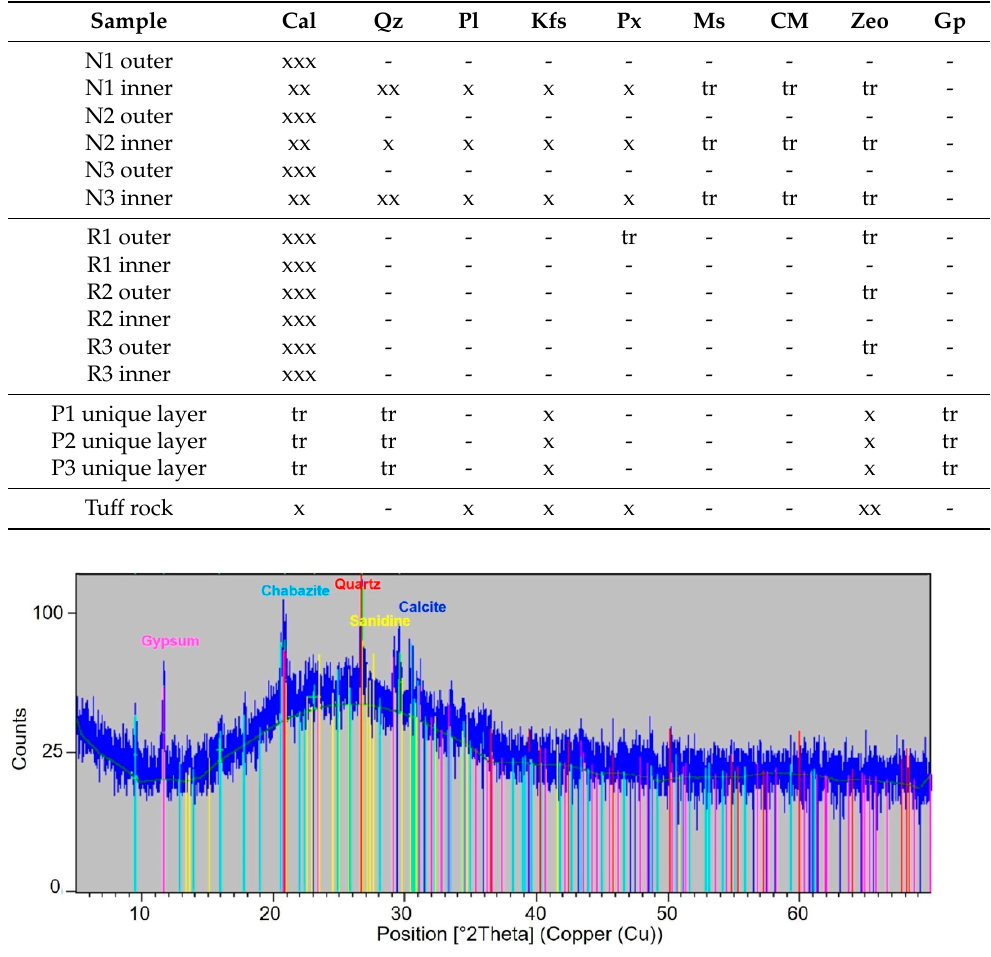
Figure 5. X-ray diffraction pattern obtained for the sample P1. The different identified compounds are reported in correspondence of the main peaks. Table 2. XRD results of the analysis of the preparatory layers. Cal, calcite; Qz, quartz; Pl, plagio- clase; Kfs, K-feldspar; Px, pyroxene; Ms, mica; CM, clay minerals; Zeo, zeolite; Gp, gypsum. xxx, high amount; xx, medium amount; x, low amount; tr, traces.